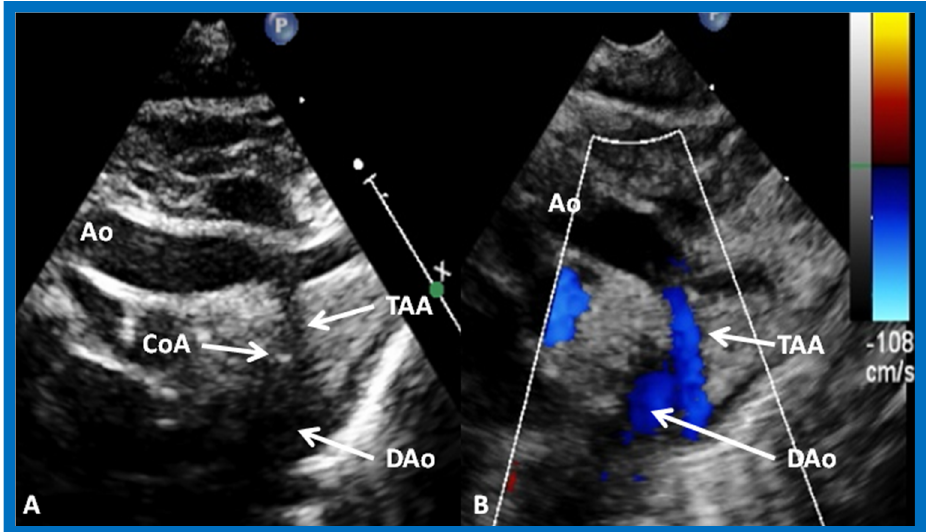
Figure 26. Selected video frames from suprasternal notch views of the aortic (Ao) arch in 2D ( A ) and color flow ( B ) images of a neonate with tricuspid atresia and transposition of the great arteries demonstrating coarctation of the aorta (CoA) and hypoplastic transverse aortic arch (TAA). The association of CoA with tricuspid atresia plus transposition of the great arteries is well known. DAo, descending aorta. Reproduced from Rao P.S. [39].